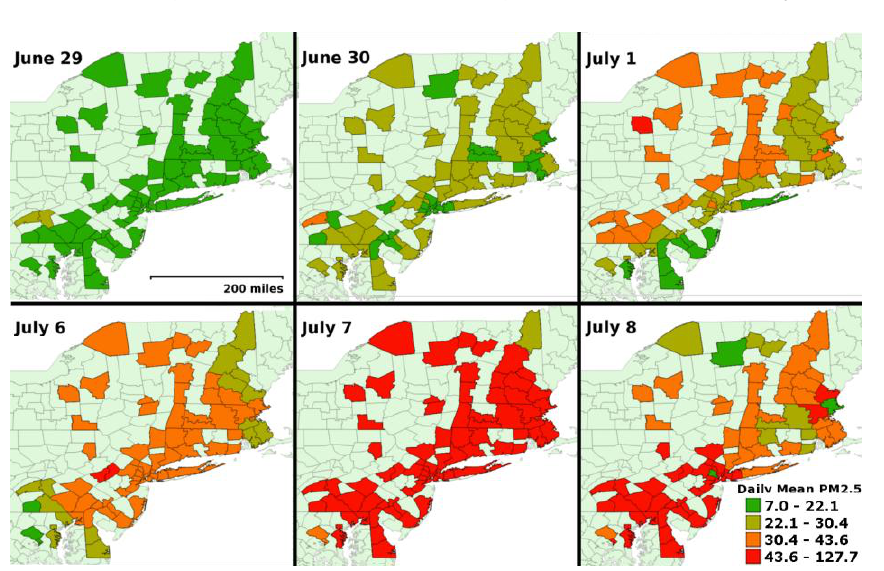
Table 2. Summary statistics for the block kriged estimated county average PM